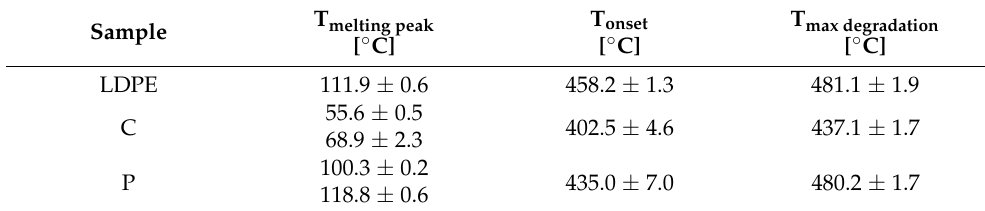
Table 4. Thermal properties of low-density polyethylene (LDPE), fully hydrogenated cottonseed oil (C), and paraffinic wax (P): temperature at the melting peaks (T melting peak ) from the DSC analyses, onset decomposition temperatures (T onset ) from the TG curves, and maximum degradation temperatures (T max degradation ) from the DTG curves.